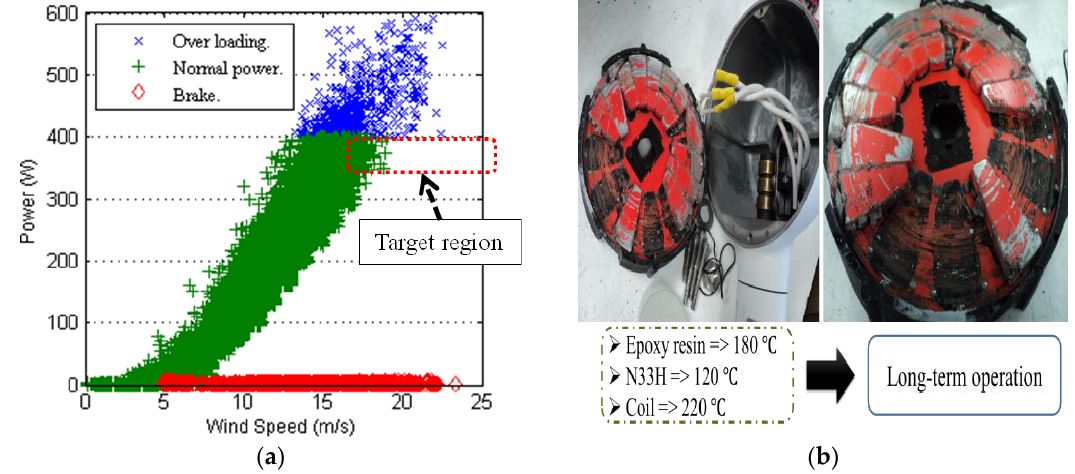
Figure 2. ( a ) Monitoring data of the 400 W HAWT; and ( b ) damage of the generator of the 400 W HAWT.